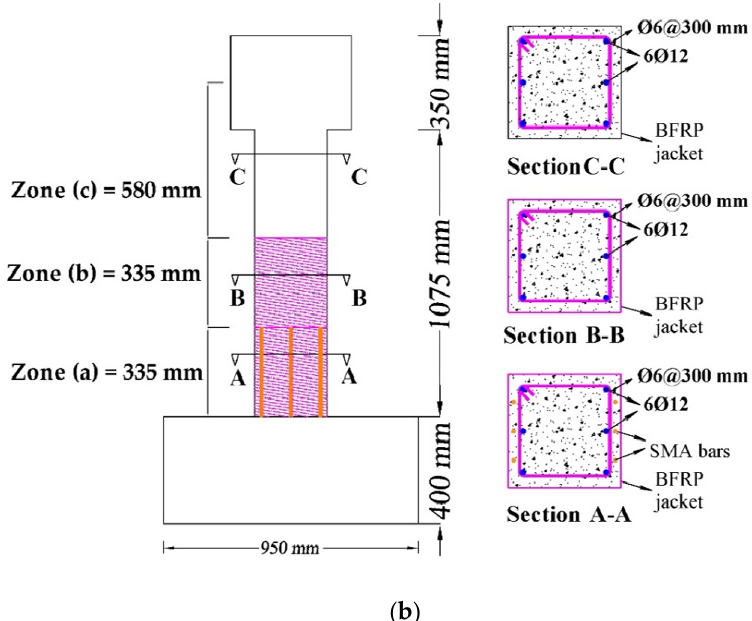
Figure 3. Schematic showing the proposed retrofitting technique: ( a ) Circular cross-section column; ( b ) rectangular cross-section column.